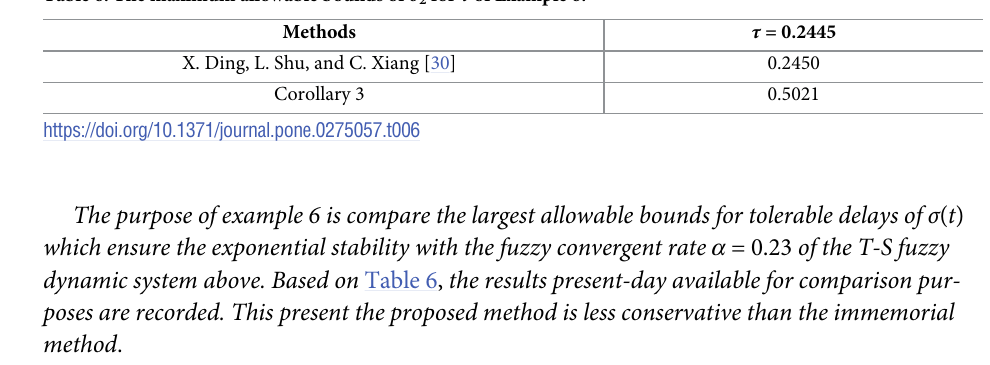
Table 6. The maximum allowable bounds of σ 2 for τ of Example